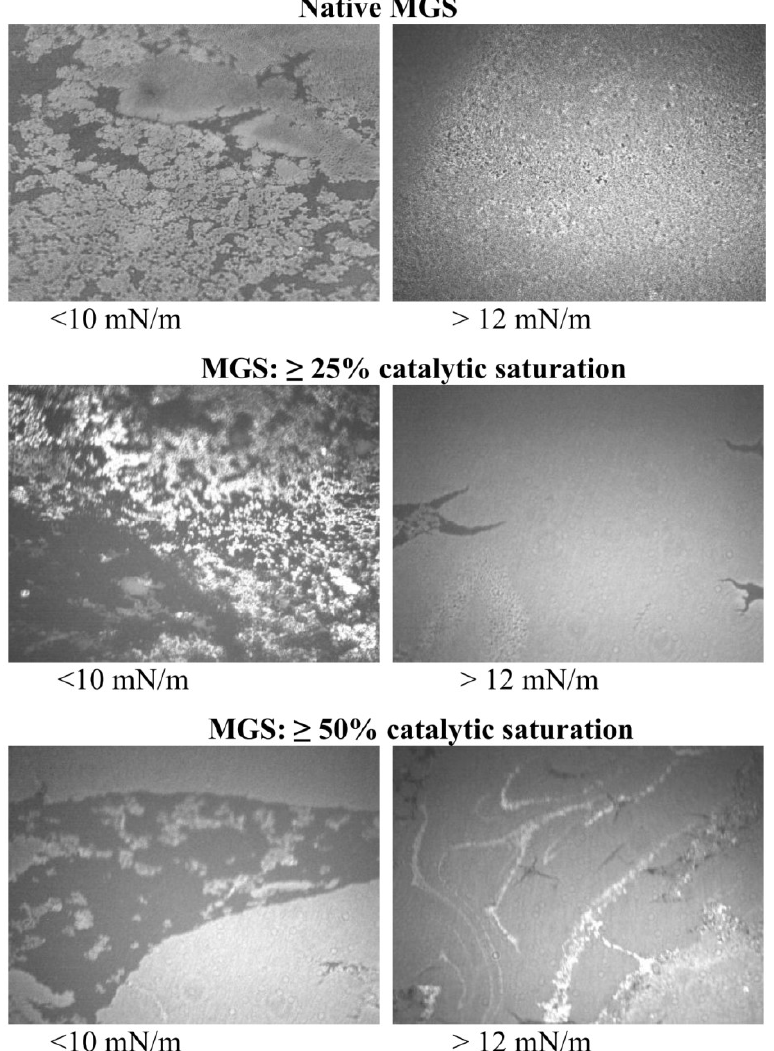
Figure 3. Brewster angle microscopy (BAM) micrographs (3000 µm × 3000 µm; 40× magnification) of MGS films with different degrees of catalytic saturation. The intensity of the right panel images is intentionally attenuated for better visual perception.